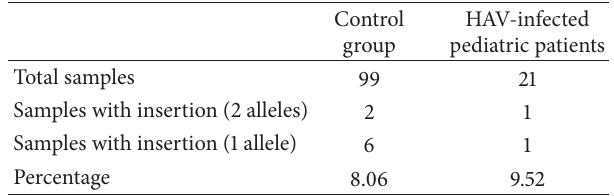
Table 2: The frequency of the 157insMTTTVP insertion in HAVCR1/TIM1 gene in healthy donors and HAV-infected patients.